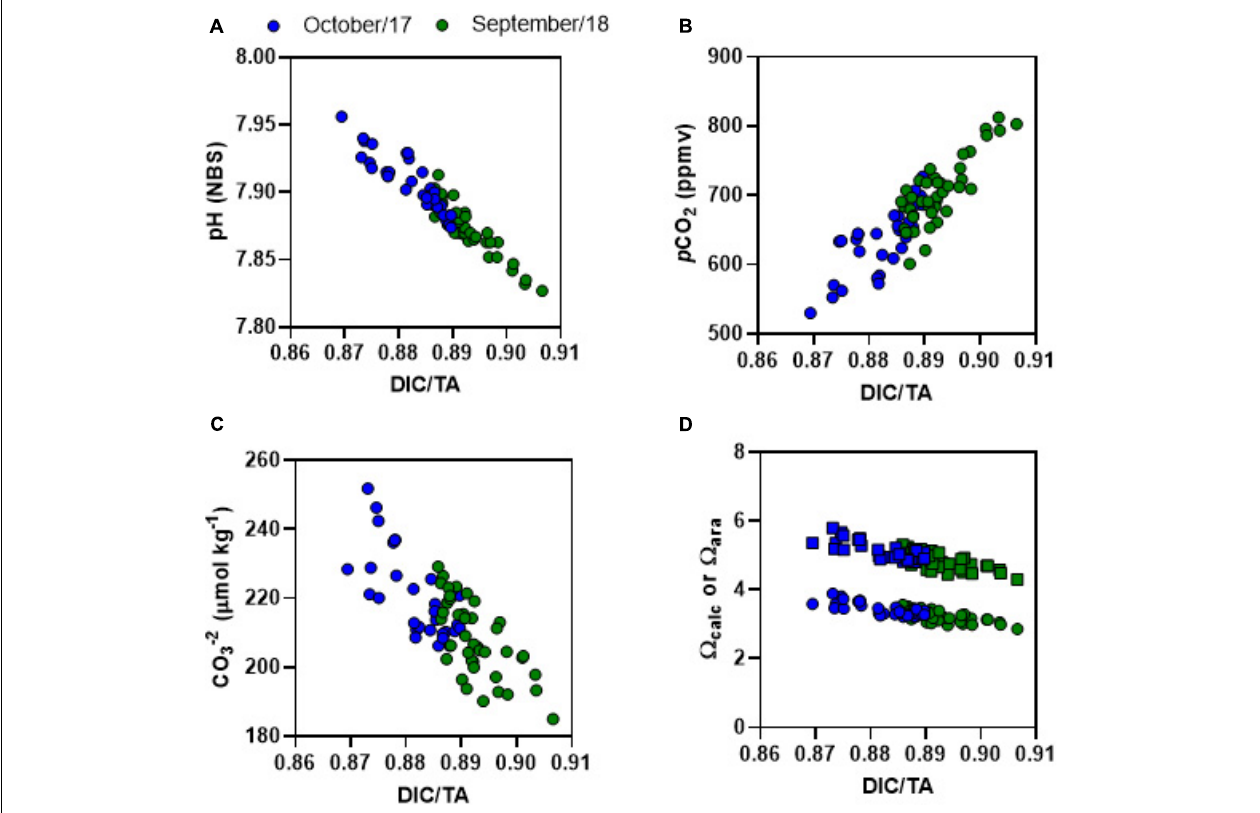
FIGURE 7 | DIC/TA ratio plotted against (A) pH, (B) p CO 2 , (C) CO 32 − , and (D) (cid:127) calc (squares) or (cid:127) ara (dots). Blue dots represent Oct-2017 and green dots represent Sep-2018.